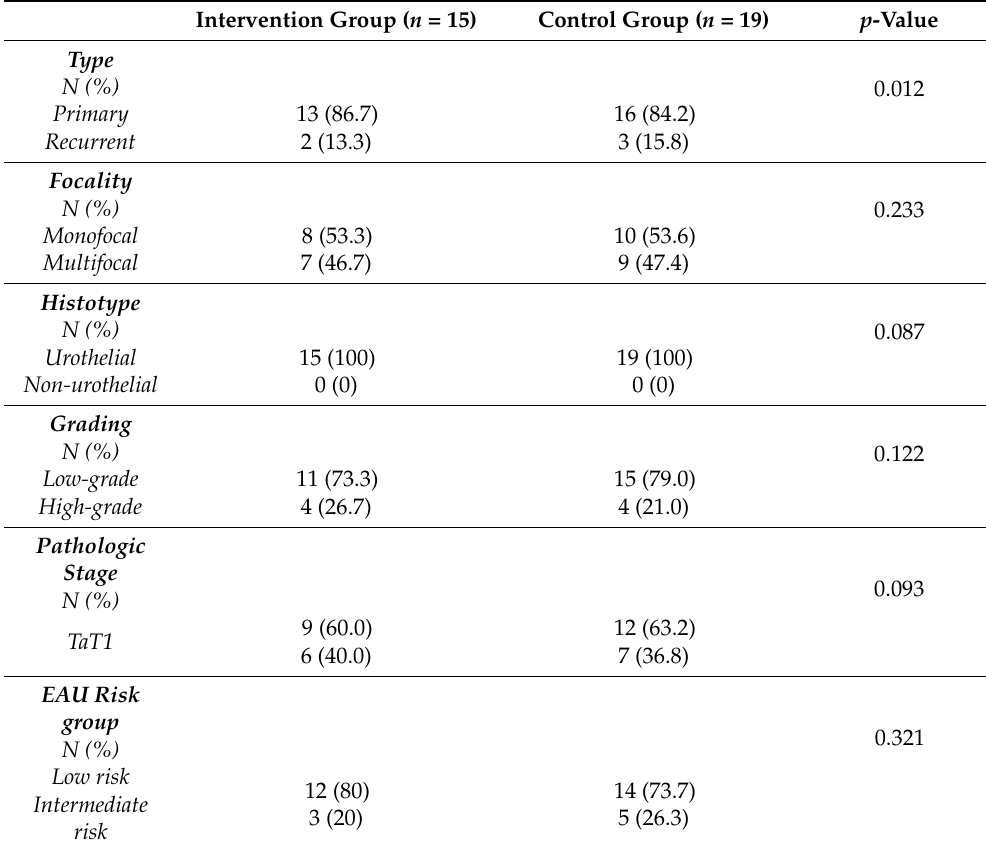
Table 2. Bladder tumors’